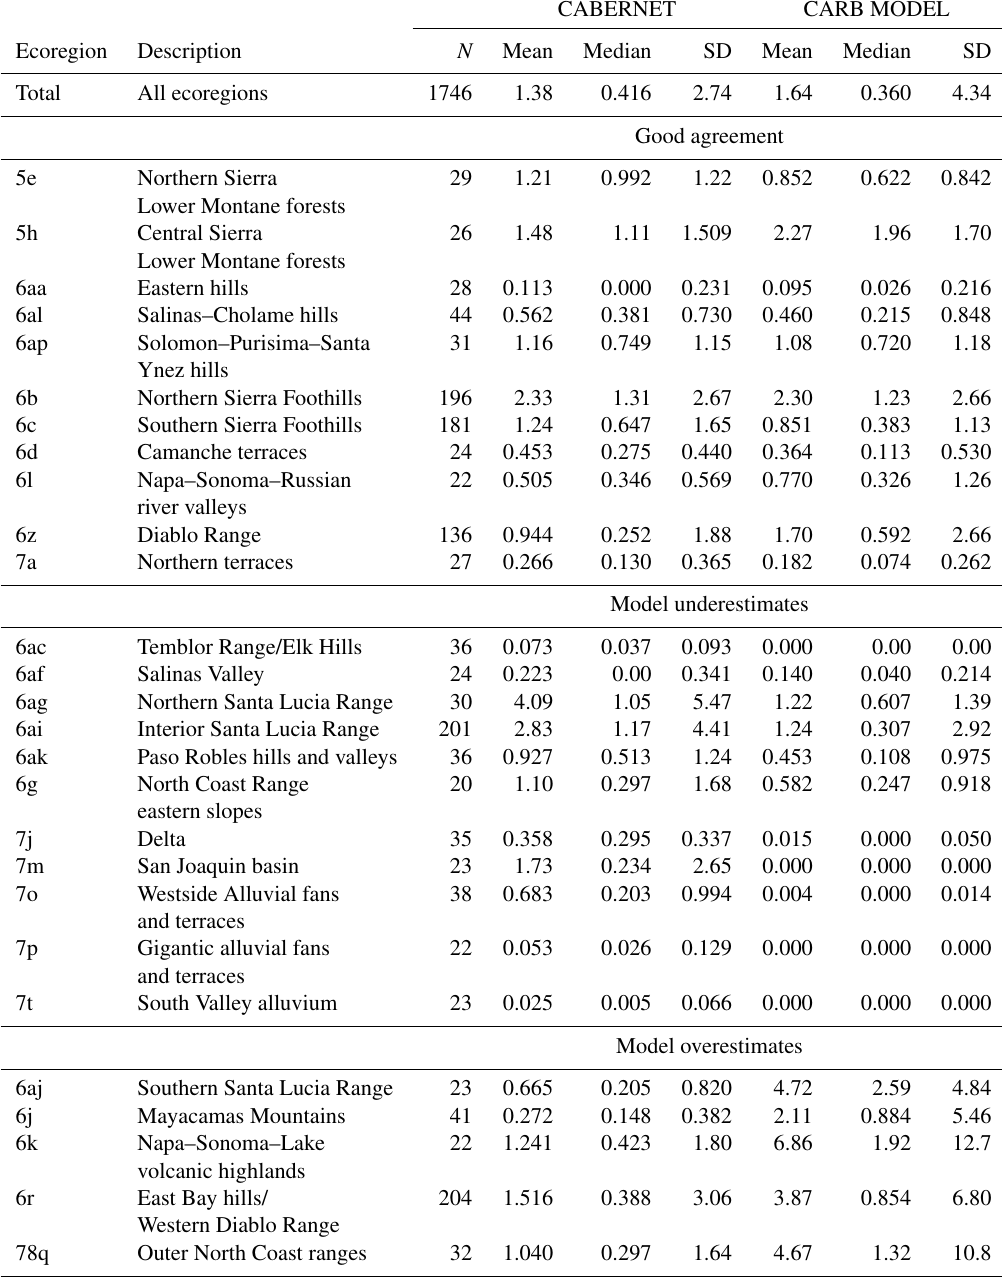
Table 2. Summary quantitative statistics for CABERNET and CARB model’s emissions (kgh − 1 ) ∗